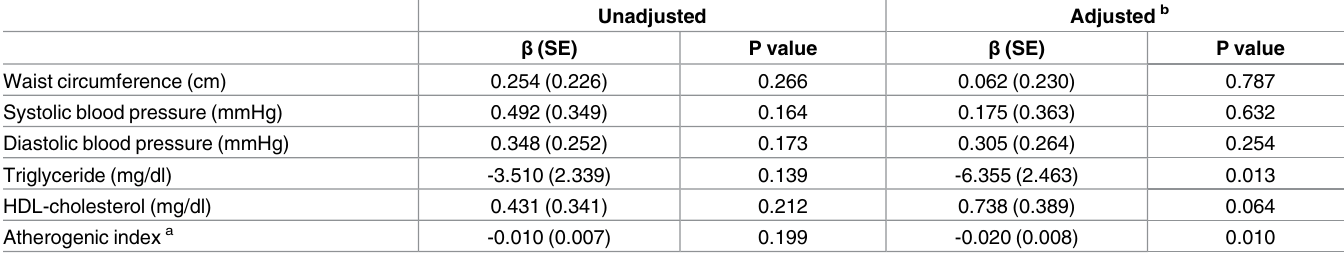
Table 4. Linear regression coefficients between serum 25(OH)D level and metabolic outcomes among Korean prediabetic